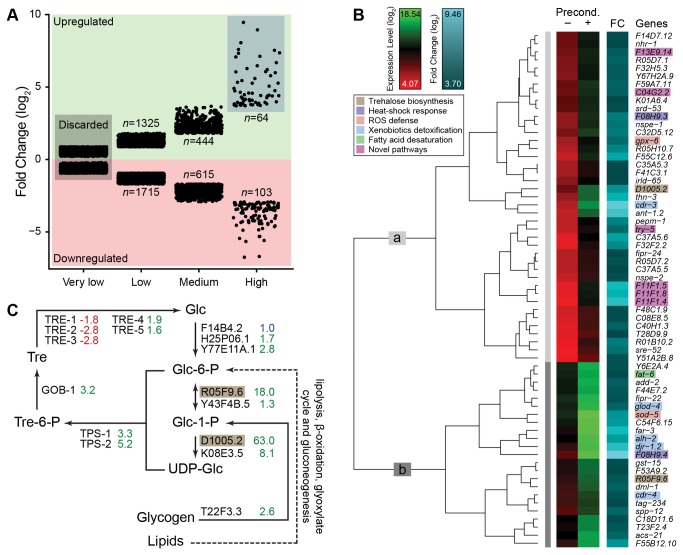
Analysis of desiccation-induced DTR mRNAs.(A) Fold change clustering of upregulated (green area) and downregulated (pink area) genes. The very low FCC was discarded because the differential expression was too low. The number of genes (n) in each group is shown. (B) Hierarchical clustering of the 64 highly upregulated genes (blue region in panel A). Red/green column shows log2 expression levels before (–) and after (+) preconditioning, cyan column shows log2 fold changes for the genes indicated on the right. Color codes for the heat map are shown top left. Main branches of the dendrogram are labeled ‘a’ (light gray) and ‘b’ (dark gray, see the text for details). Highlighted genes reside in essential anhydrobiotic pathways shown in the legend with unique color codes, which are consistent in the following figures. (C) The trehalose biosynthesis pathway is upregulated in C. elegans upon desiccation stress. Enzymes that catalyze each reaction are shown with the corresponding differential expression values of their transcripts upon preconditioning. These fold changes are shown in green, red, and blue for upregulation, downregulation, and no change, respectively. Glucose-6-phosphate synthesis from lipids involves several steps; therefore, a dashed arrow is used. Highlighted genes are found in the high FCC (panel B). Glc, Glucose; Glc-6-P, glucose-6-phosphate; Glc-1-P, glucose-1-phosphate; UDP-Glc, UDP-glucose; Tre-6-P, trehalose-6-phosphate; Tre, trehalose.